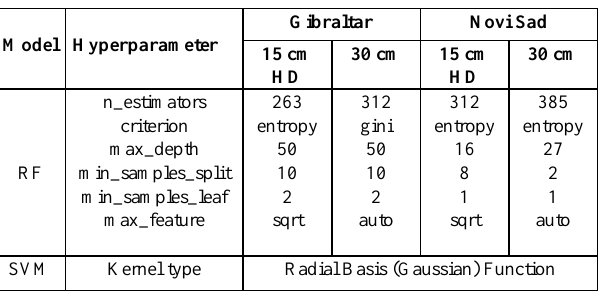
Figure 7. The RF classification result of Gibraltar MAXAR HD image.